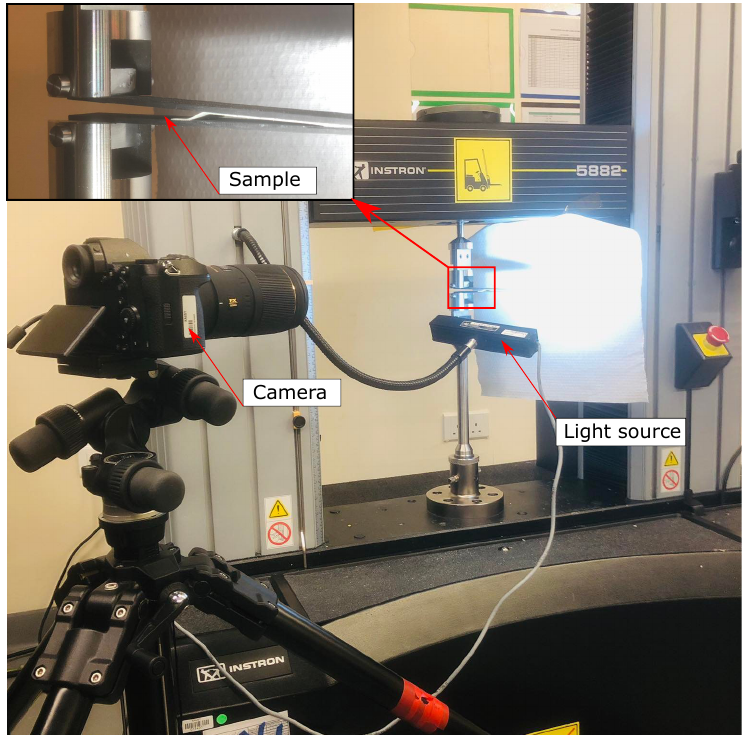
Figure 2. Experimental double cantilever beam test set